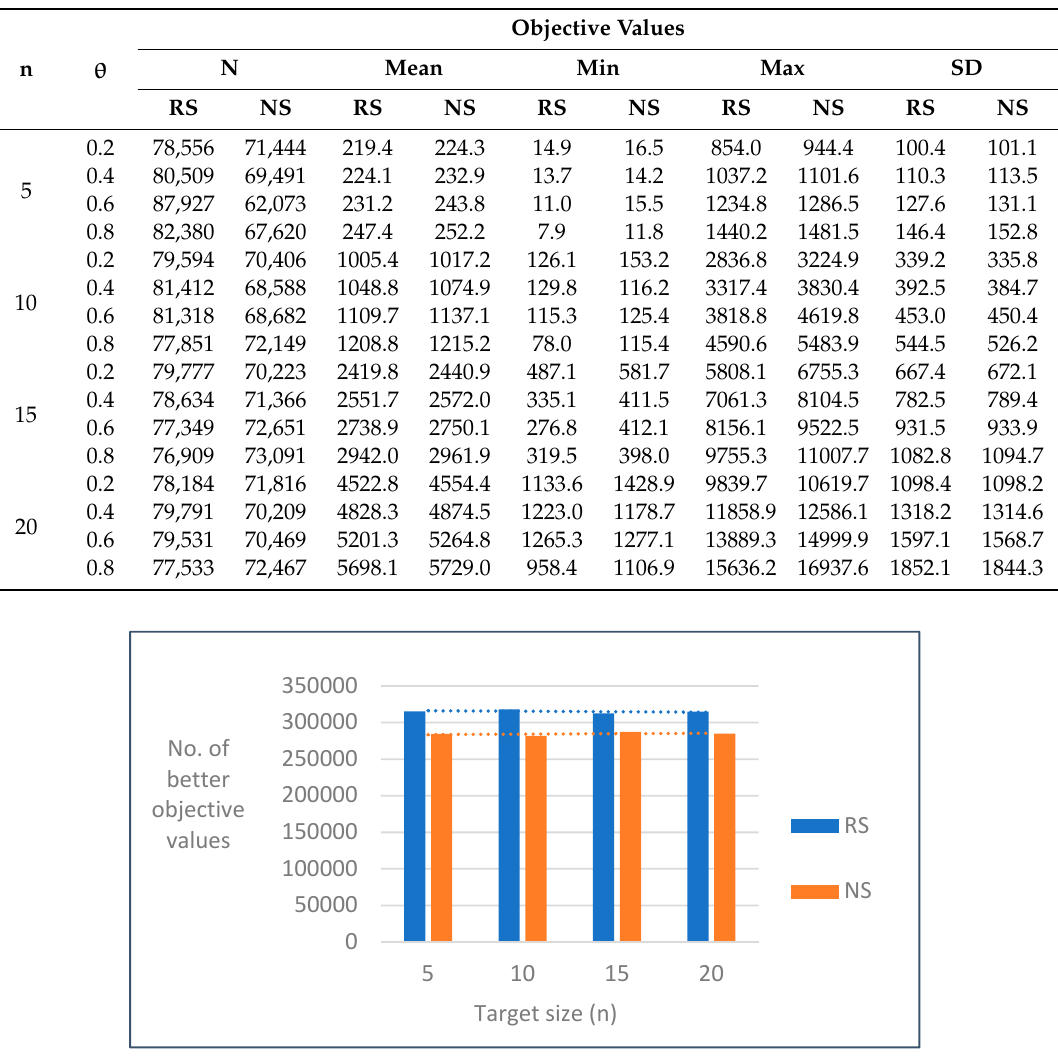
Table 4. Simulation experimental results to compare objective values at various target numbers (n) and uncertainty levels ( θ ).